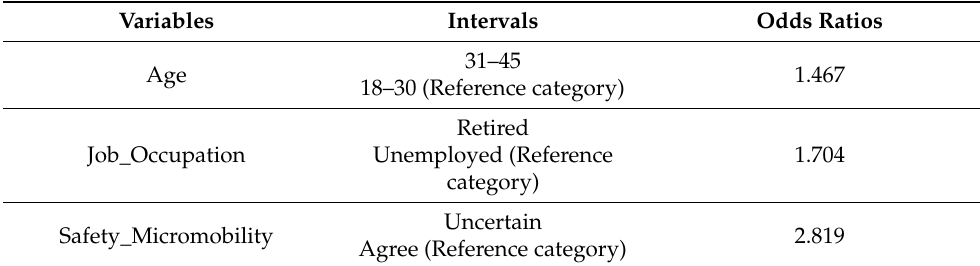
Table 7. Odds ratio results for the Gender Equality